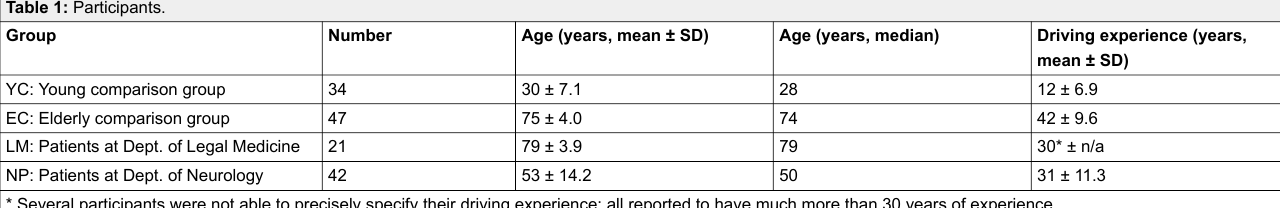
Table 1: Participants.